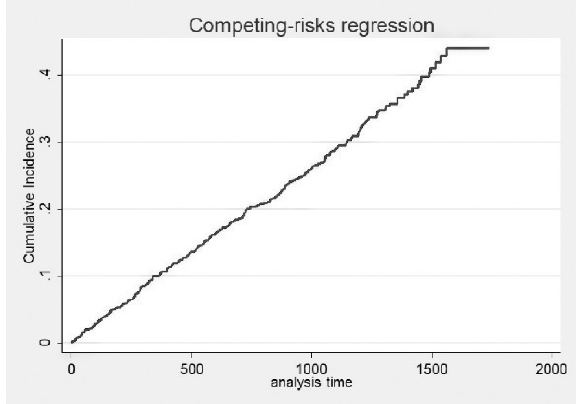
Figure 1. Cumulative Incidence Function Based on Weibull Model for Patients with Acute Renal Failure.